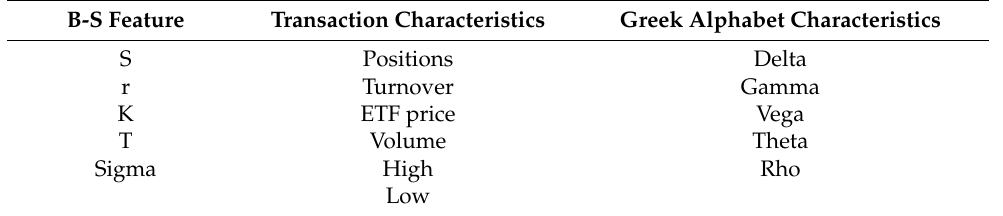
Table 1. To select a list of